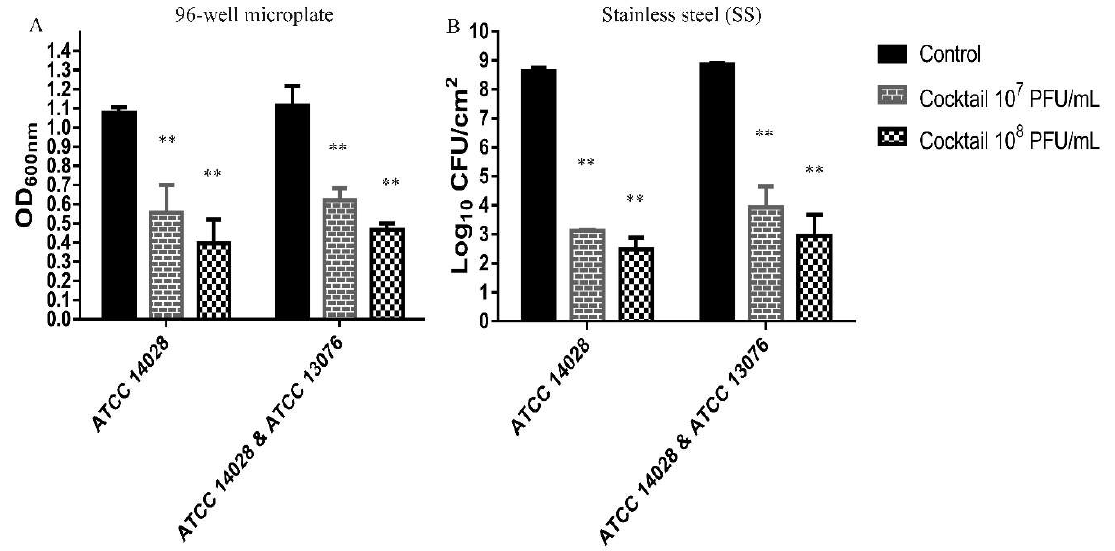
Figure 6. E ff ect of phage cocktail on biofilm. ( A ) E ff ect of phage cocktail on 72-h-old biofilm in 96-well Figure 6. Effect of phage cocktail on biofilm. ( A ) Effect of phage cocktail on 72-h-old biofilm in 96- microplate and ( B ) on stainless steel surface at 30 ◦ C after 24-h post-infection. Values represent mean well microplate and ( B ) on stainless steel surface at 30 °C after 24-h post-infection. Values represent with standard deviation of five determinations. ** Significant at p < mean with standard deviation of five determinations. ** Significant at p < 0.01.